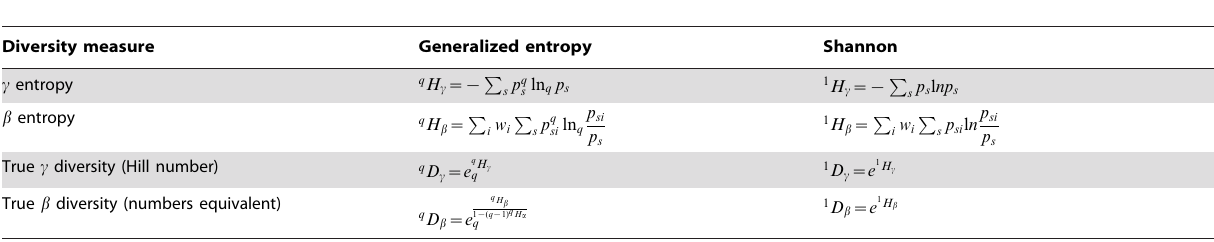
Table 1. Values of entropy and diversity for generalized entropy of order q and Shannon